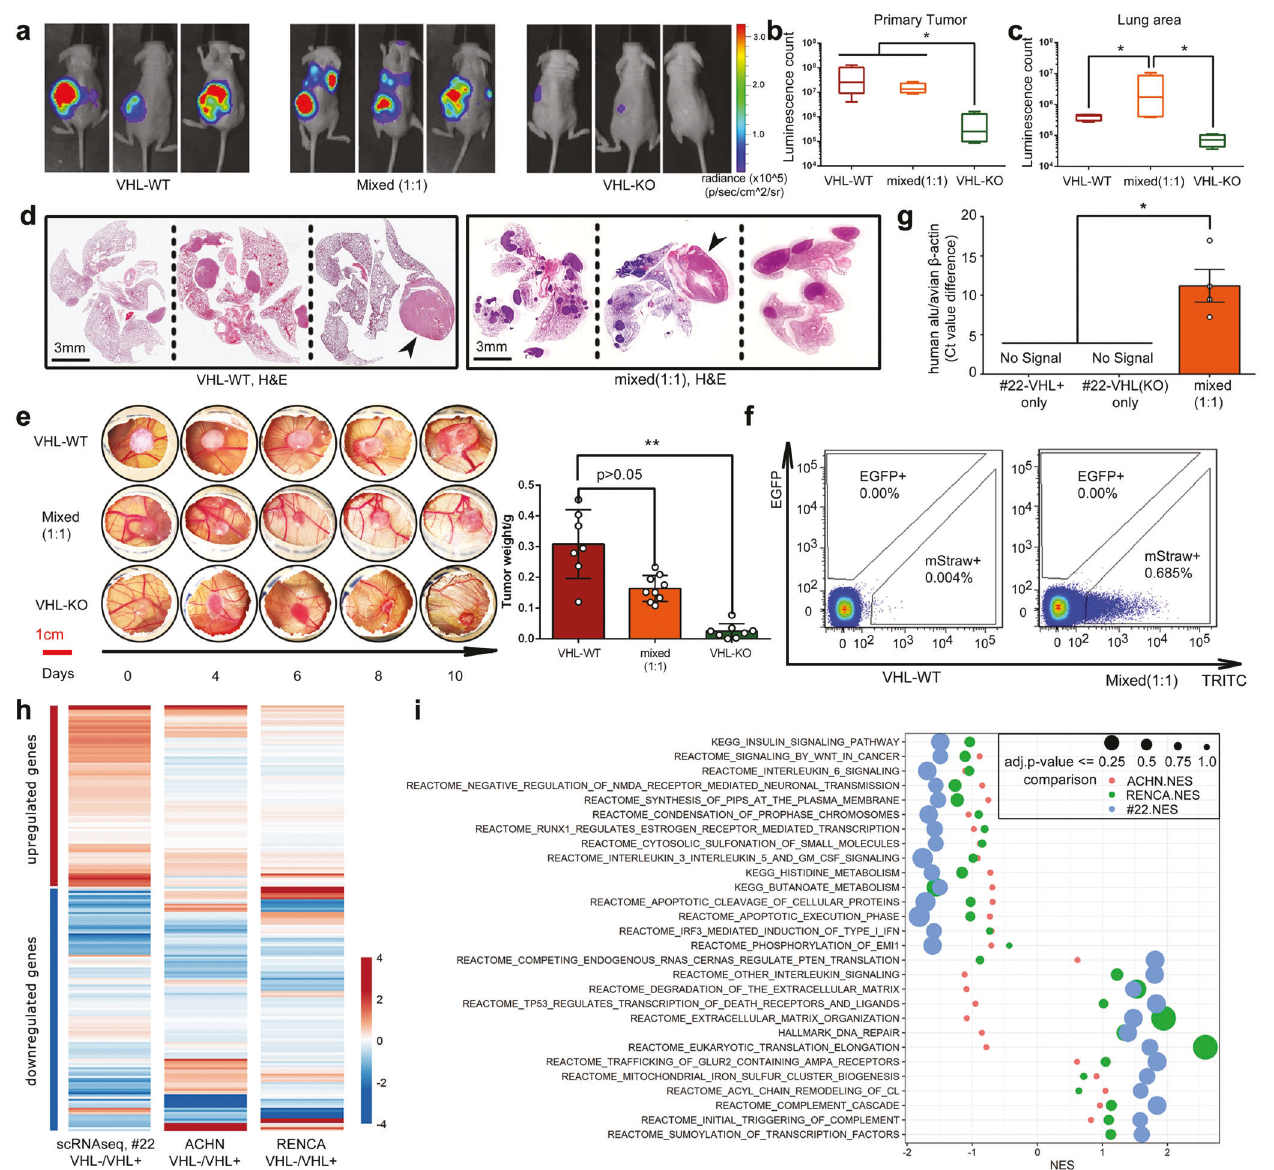
Fig. 2 VHL-KO cells cooperate with VHL-WT cells to cause metastasis. a Mice were implanted with a total of 1 × 10^6 tumor cells, either RC- VHL-WT, RC-VHL-KO, or a 1:1 mixture of the two cell types, into their left kidney ( n = 6 per group). Images of three representative animals assessed by BLI on week 4 post-implantation are shown. b Primary tumor indicated by BLI in different groups are shown at the end point. c Lung metastases are indicated by elevated BLI signals in the thoracic cavity in the mixed tumor group. One-way ANOVA was used to test the statistical signi fi cance in ( b ) and ( c ) with n = 6, presented with mean ± SD. d H&E-stained sections (low magni fi cation) of lung and heart of each animal in the RC-VHL-WT tumor group and mixed (1:1) tumor group. Arrowhead indicates the heart. Scale bar: 3 mm. e RC tumor growth was assessed in the CAM tumor system through longitudinal observation. Day 0 is the day of tumor cell implantation, which occurred on day 7 postfertilization. Scale bar: 1 cm. One-way ANOVA was used in the comparison with n = 9, presented with mean ± SD. f Flow cytometric analyses of CTC from chick embryos, bearing either VHL-WT cells (marked with mStrawberry) or 1:1 VHL-WT and VHL-KO (marked with EGFP) mixed CAM tumor, harvested on day 21 post-fertilization. g In the CAM tumor system, the metastasis in the duck liver can only be seen in mixed implantation of primary tumor cells from #22 and its VHL-KO counterpart as analyzed by TaqMan probes for human alu sequence and avian β -actin. n = 5 with “ no signal ” sample dots not shown and Ct value differences are presented with mean ± SEM. h Heatmap of the top 200 genes based on conserved gene expression patterns across comparisons of #22 VHL + vs. VHL − cells in single-cell sequencing (as noted in Fig. 1f), VHL KO vs. VHL WT ACHN models, and VHL KO vs. VHL WT RENCA models. Heatmap colors represent log2 fold changes z -score scaled by column. Detailed information is listed in Supplementary Table 2. i Top 30 gene sets based on conserved enrichment scores across the same three comparisons are listed. The color of points represents the differential expression comparison (ACHN VHL-KO vs VHL-WT as red, RENCA VHL-KO vs VHL-WT as green, and the single cell comparison of #22-VHL + vs VHL − as blue) and the size of the points corresponds to the adjusted p -value from GSEA, in which the bigger circles indicate up/down-regulation with lower p -values. (* p < 0.05, ** p < 0.01) (not consistent with adjusted p vals in Fig.